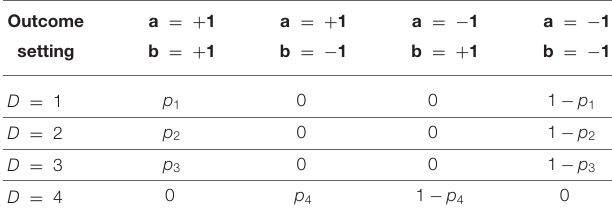
a , E b , and TABLE 2 | Conditional probabilities for a toy model with a single input with four E possible values and two binary outcomes. Outcome